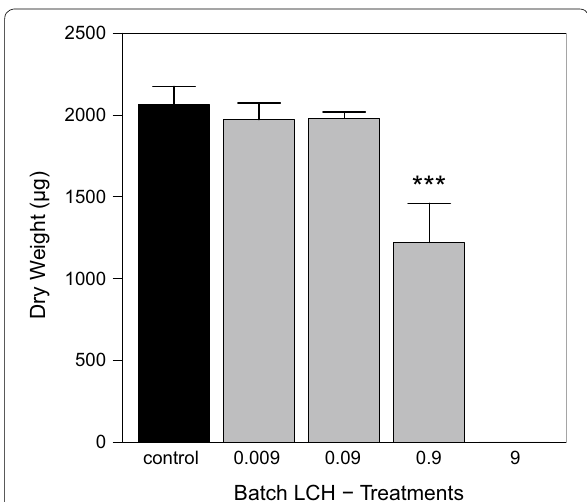
Fig. 14 Grazer triglyceride contents at the end of the LCH batch experiment [mean SE, n 4]. All LCH treatments in µg g − 1 OC. ± = * significantly different from control with p <